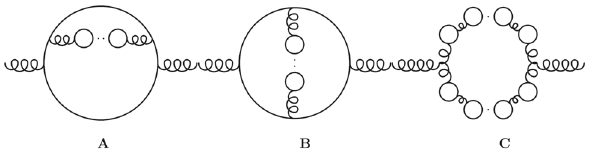
Fig. 2 Next-to-leading order diagrams. C is one representative of the diagrams containing gauge boson self-interactions